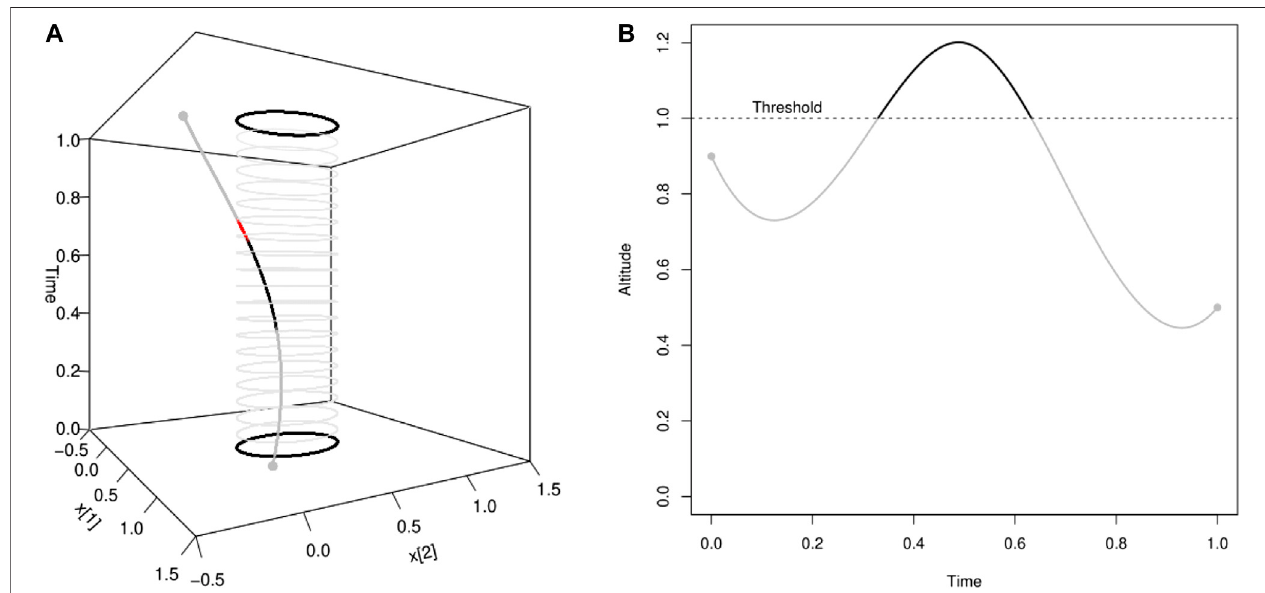
FIGURE 3 | Illustration of pointwise connectivity based on a covariate measured along the trajectory: (see Example 2.8). In this illustration, the passage of the particle in the elliptic spatial domain A contributes to the pointwise connectivity [red part of the curve in Panel (A) ] only when the particle is at an altitude lower than a threshold value [grey part of the curve in Panel (B)